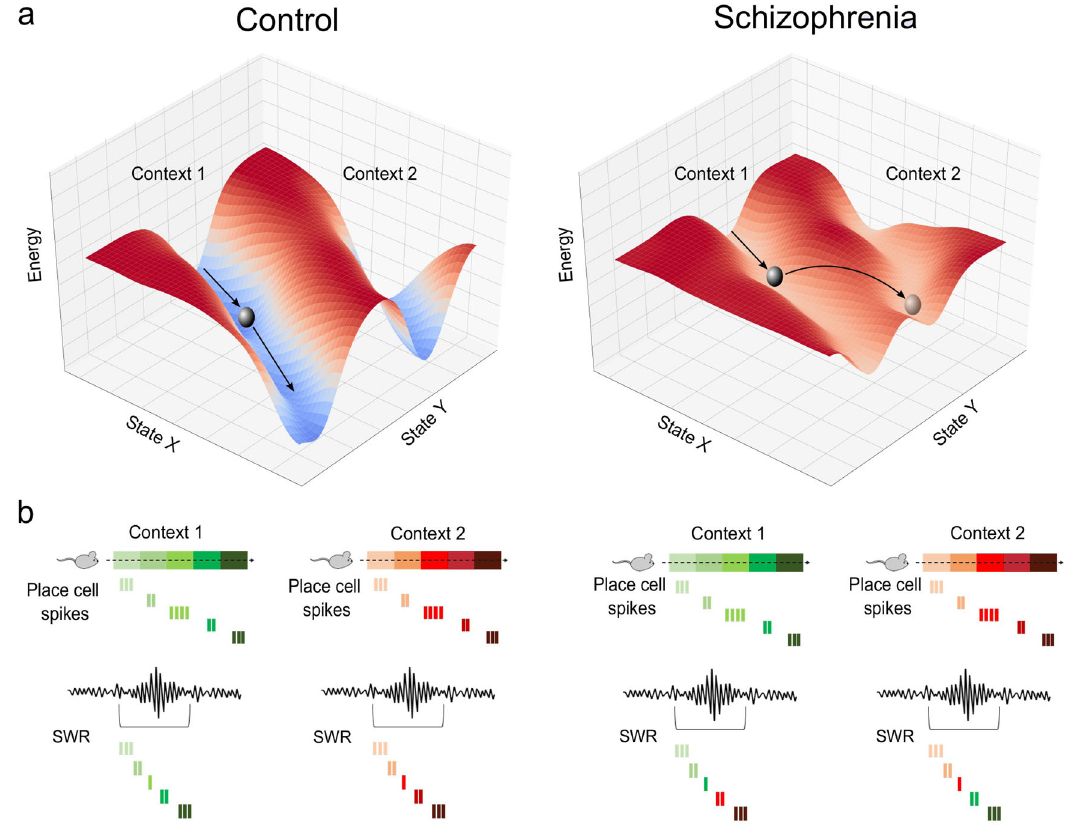
Fig. 1 Shallow attractors and disorganized cognitive maps in Schizophrenia. a Hypothetical neural state space representing the stability of distinct ensemble activity patterns (only two state dimensions, X and Y , are shown for simplicity). In controls, attractors (valleys) representing distinct contexts are stable and well-separated by relatively low stability states (hills). This stability is hypothesized to be reduced in Schizophrenia, whereby attractors for distinct contexts are relatively shallower. b A hypothetical instantiation of shallow attractors in Hippocampal cognitive mapping. In controls, place cell activity during learning is replayed during Sharp Wave Ripples (SWRs) that occur at rest. Sequences of place cell activity from different contexts are replayed separately. This re fl ects deep attractors, requiring greater jumps in energy barriers to move between attractors of distinct memories. In Schizophrenia, place cell activity during learning is replayed during SWRs, however, replay is disordered. This may arise due to shallow attractors, in which energy barriers are smaller and easier to cross, making it easier to switch between memories of unrelated contexts during retrieval and hence giving rise to disordered